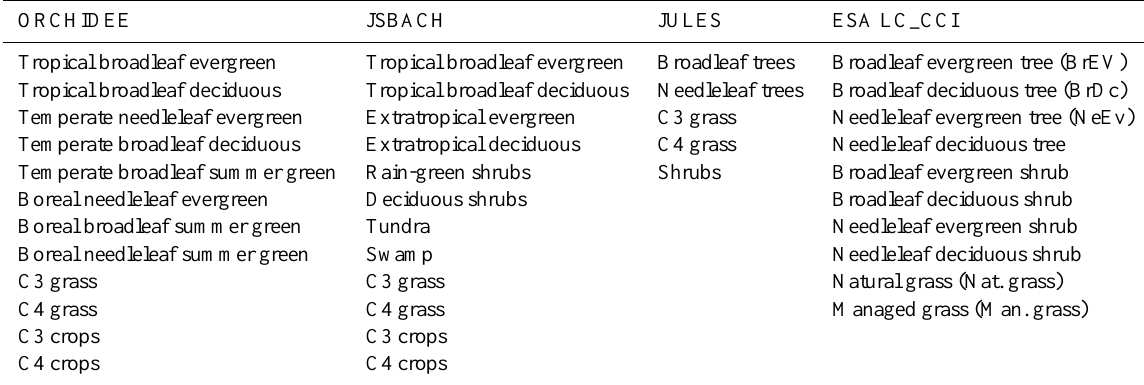
Table 1. Plant functional types used by three earth system models and mapped by the LC_CCI Initiative. ORCHIDEE JSBACH JULES ESA LC_CCI Tropical broadleaf evergreen Tropical broadleaf evergreen Broadleaf trees Broadleaf evergreen tree (BrEV) Tropical broadleaf deciduous Tropical broadleaf deciduous Needleleaf trees Broadleaf deciduous tree (BrDc) Temperate needleleaf evergreen Extratropical evergreen C3 grass Needleleaf evergreen tree (NeEv) Temperate broadleaf deciduous Extratropical deciduous C4 grass Needleleaf deciduous tree Temperate broadleaf summer green Rain-green shrubs Shrubs Broadleaf evergreen shrub Boreal needleleaf evergreen Deciduous shrubs Broadleaf deciduous shrub Boreal broadleaf summer green Tundra Needleleaf evergreen shrub Boreal needleleaf summer green Swamp Needleleaf deciduous shrub C3 grass Natural grass (Nat. grass) Managed grass (Man.